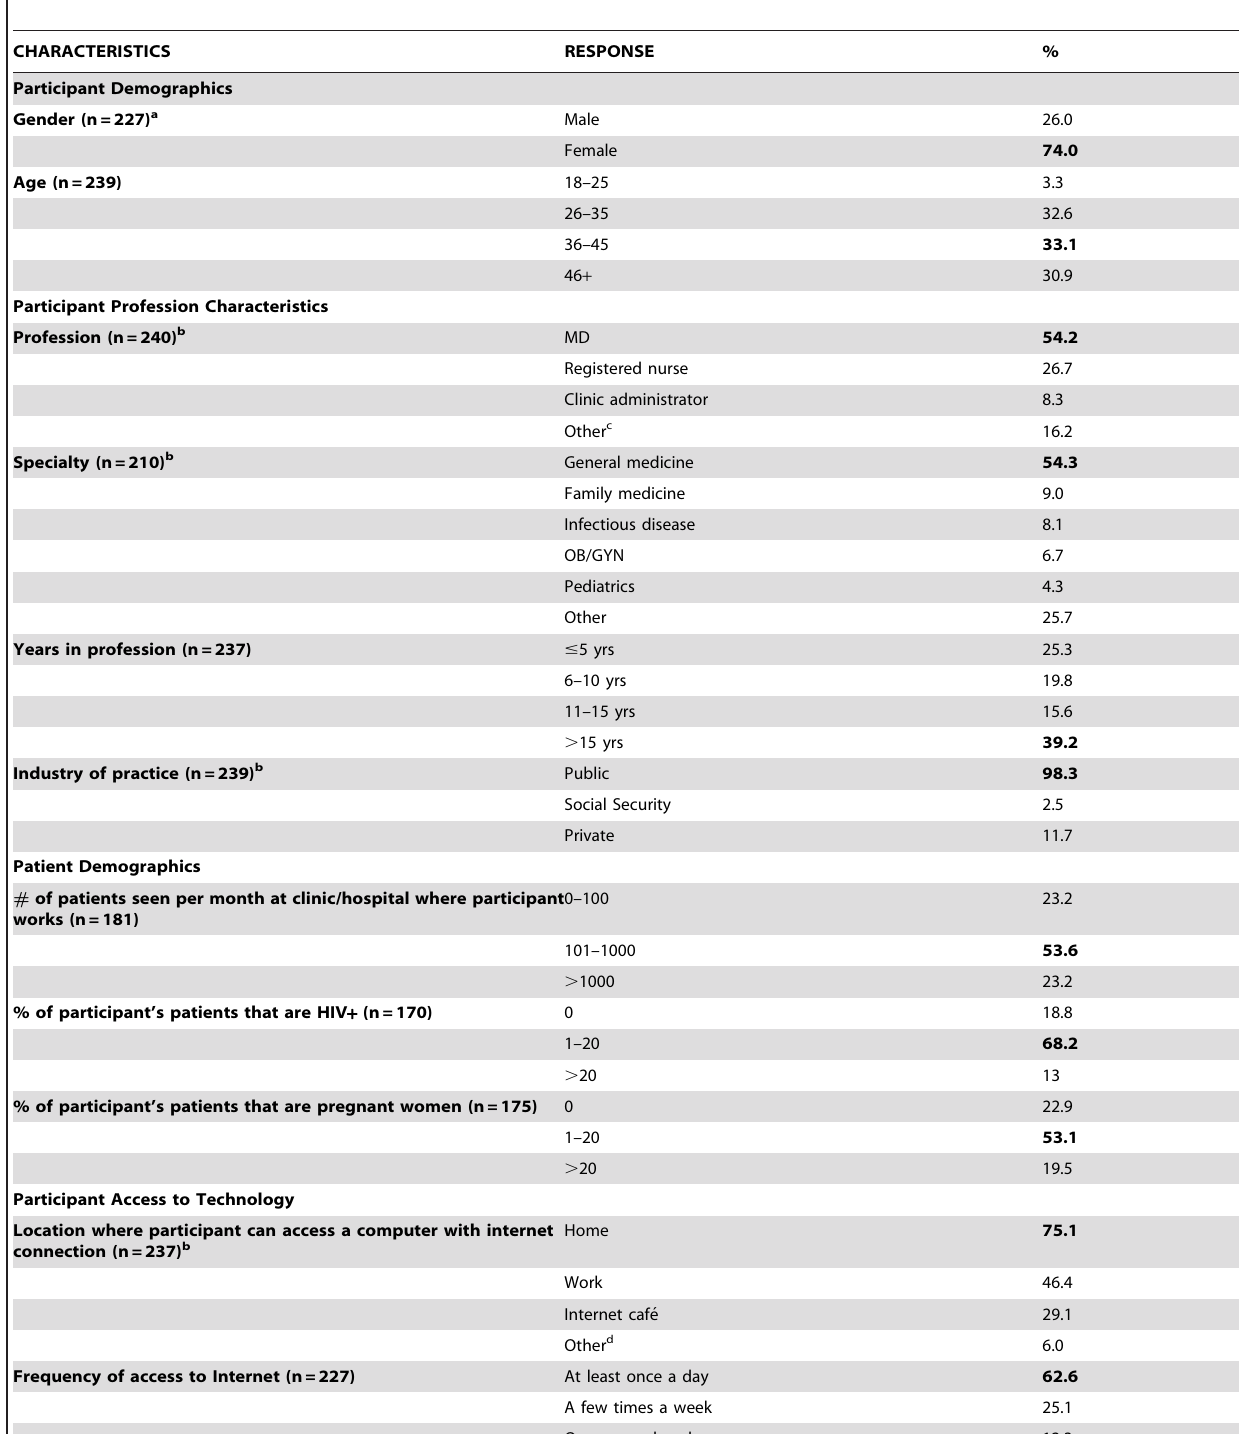
Table 1. Participant